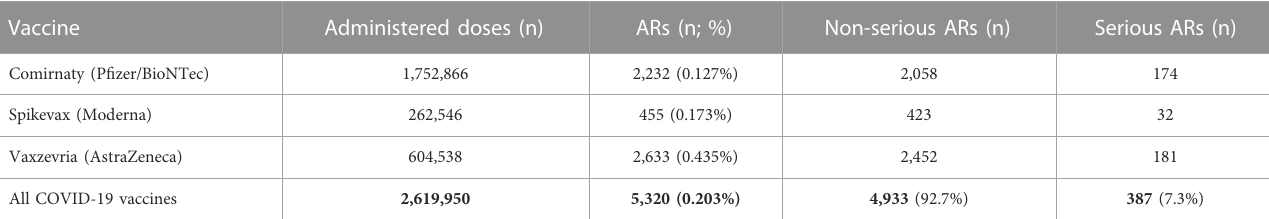
TABLE 2 Reported suspected ARs after the administration of all vaccines for the prevention of COVID-19 from 1 January 2021 to 31 May 2021. Vaccine Administered doses (n) ARs (n;